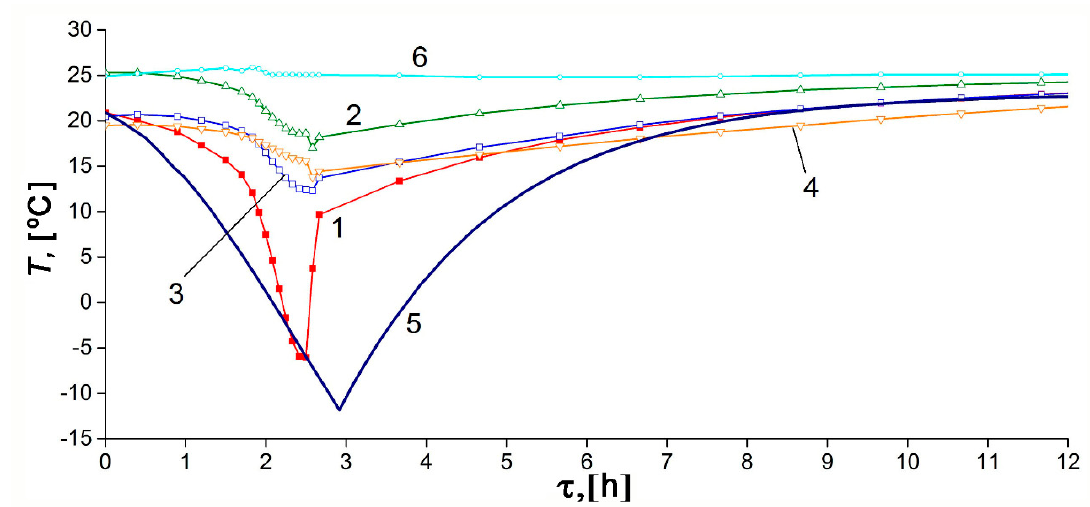
Figure 15. Temporal variations of the temperature inside and outside the adsorber during the thermally regulated discharge cycle: curves 1–4 correspond to the TE1–4 sensors readings, respectively; curve 5 is the average adsorber temperature calculated from the model, curve 6 is the ambient temperature. The average coolant temperature is 23 °C.